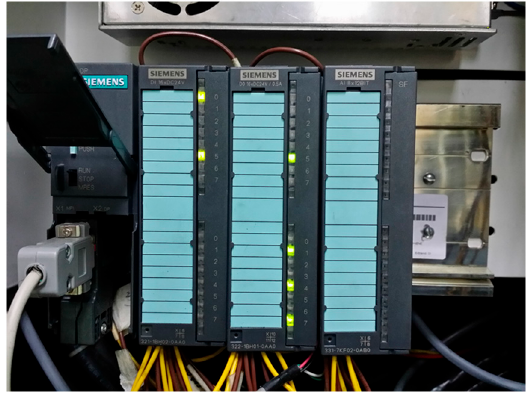
Figure 9. Programmer logic controller (PLC).